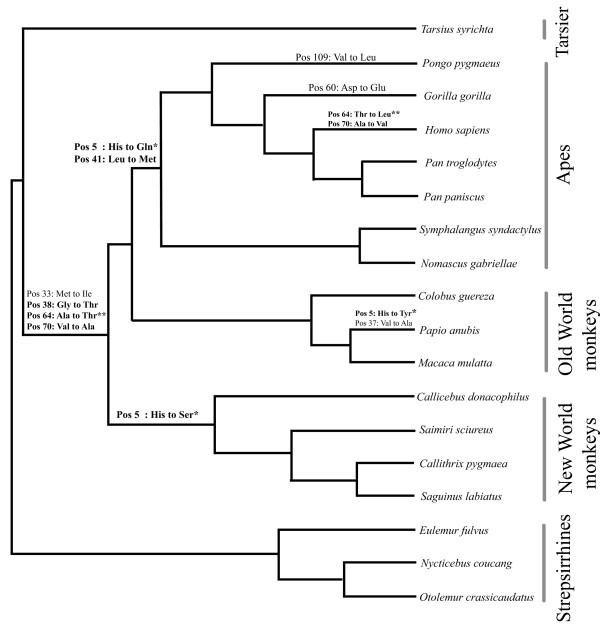
Phylogenetic tree depicting amino acid replacements inferred in COX5Ap within the anthropoid clade determined via maximum parsimony (ACCTRAN and DELTRAN) as implemented in PAUP* [51], and the codon substitution model [52] implemented in PAML 3.15. Non-prosimian outgroup species are not shown. Bold type indicates positively selected amino acids identified via the branch site test using PAML (Table 1). * Amino acid replacements in which the charge has changed, ** amino acid replacements in which the polarity has changed.